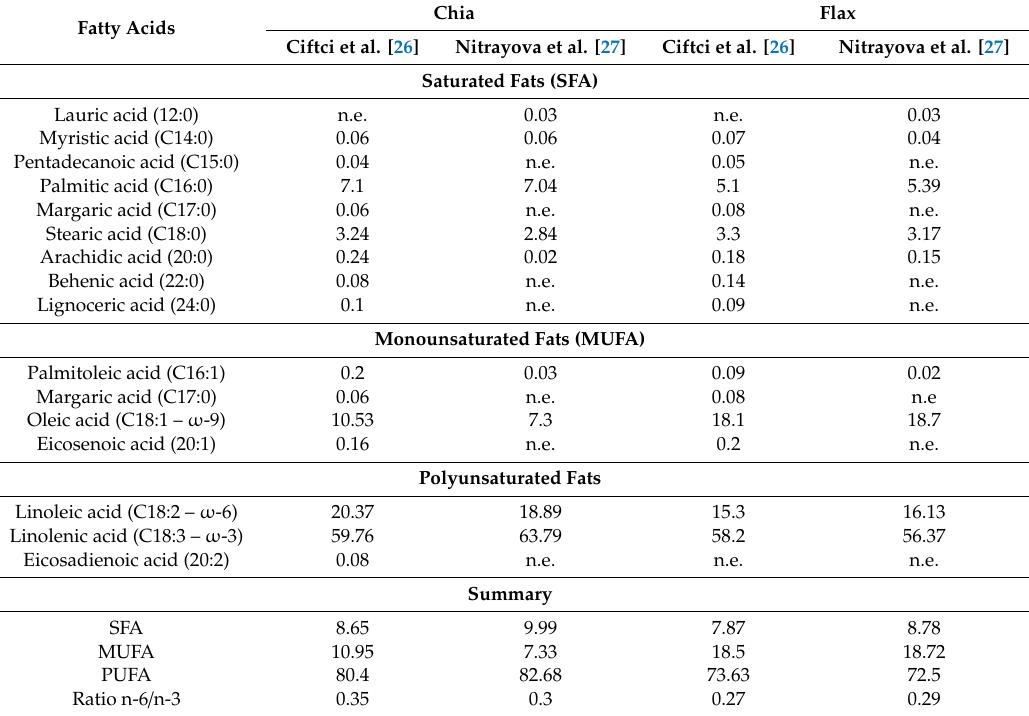
Figure 2. Fibre contents of selected foods [33]. Table 2. A comparison of fatty acid profile of chia and flax seeds (%).